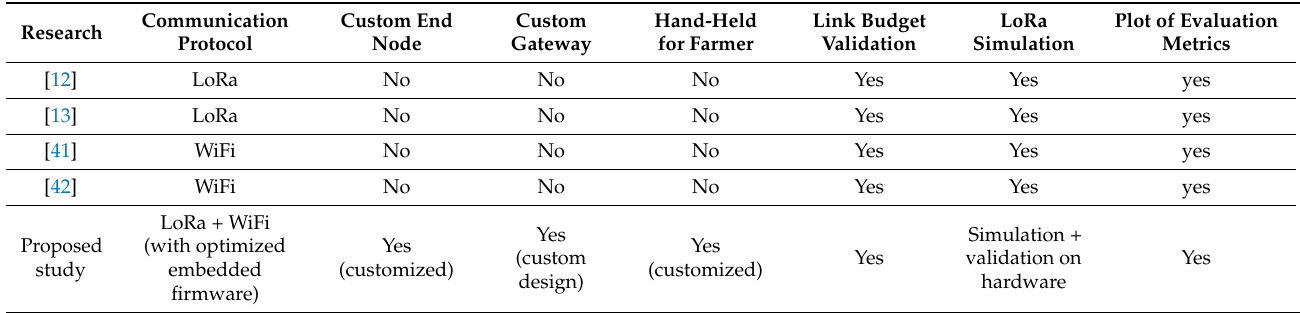
Table 9. Comparison of the LoRa-based agriculture research with the present